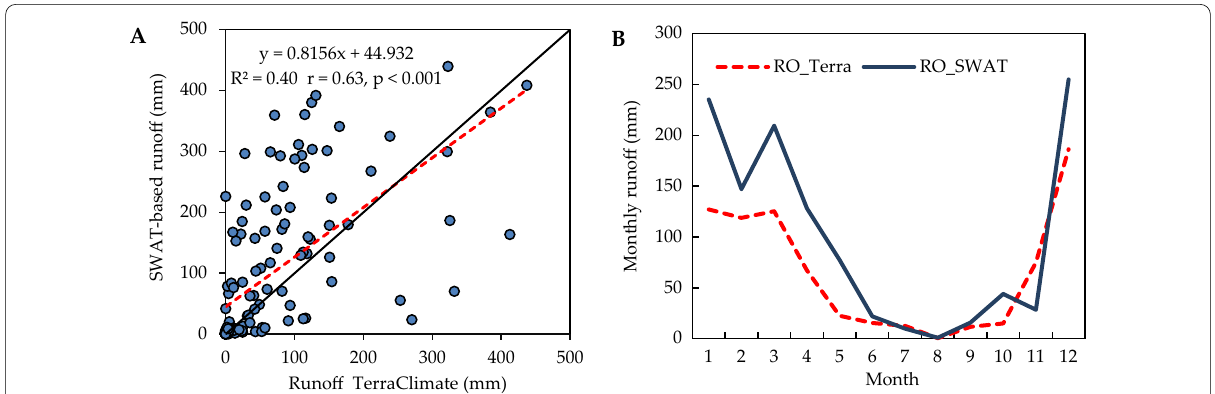
Fig. 3 The validation plot of monthly runoff from period 2003–2013 ( A ), and monthly pattern of long-term average runoff 2003–2013 ( B )